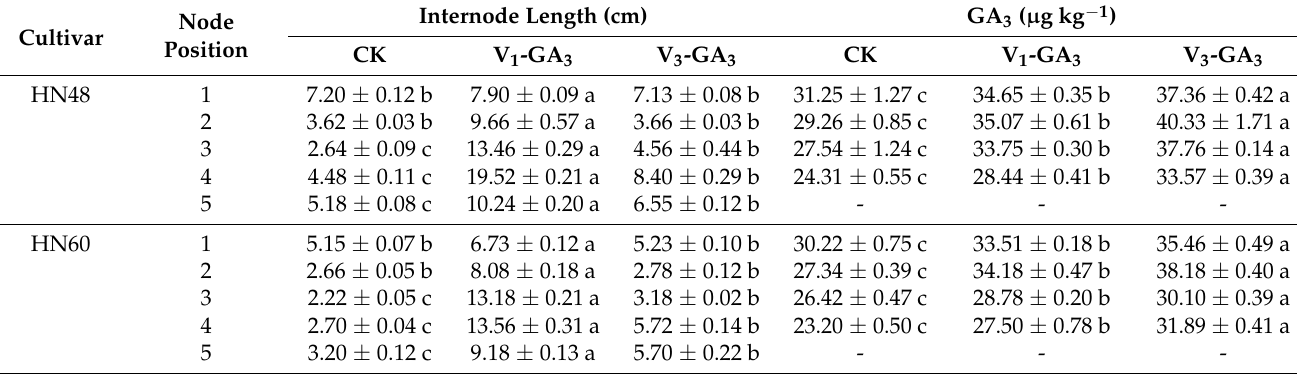
The values are presented as the means ± standard errors ( n = 8). The different letters indicate that the differences between treatments reached a significance level of 5%; the treatments are compared horizontally. V1-GA 3 : GA 3 solution (0.1 g L − 1 ) was applied to the 2nd internode in the V1 phase; V3-GA 3 : GA 3 solution (0.1 g L − 1 ) was applied to the 2nd internode in the V3 phase; CK: